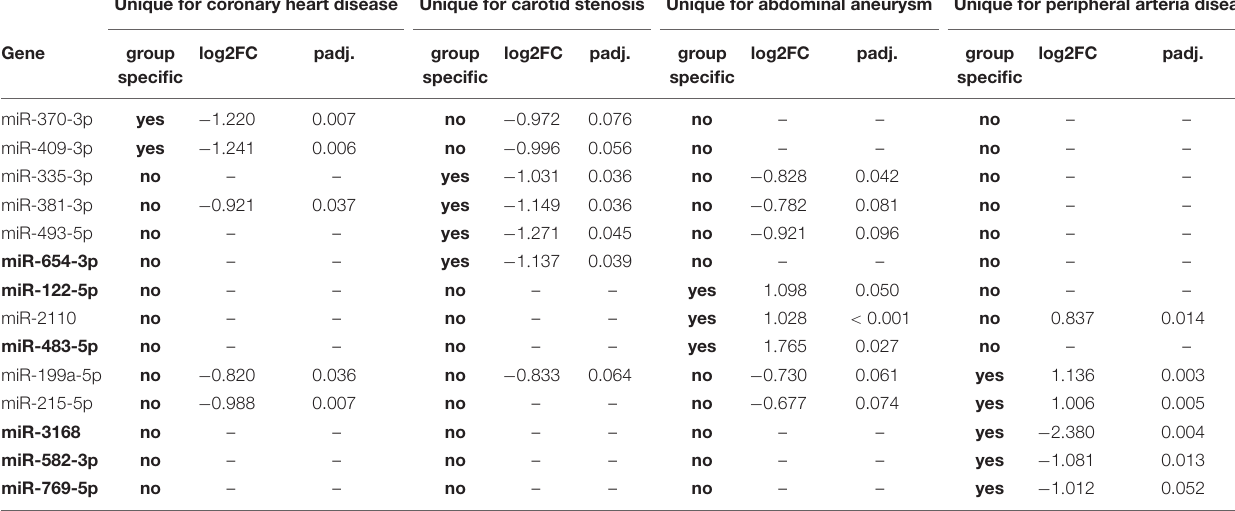
TABLE 5 | Differential expression of unique miRNAs for each atherosclerotic subgroup. Unique for coronary heart disease Unique for carotid stenosis Unique for abdominal aneurysm Unique for peripheral arteria disease padj.